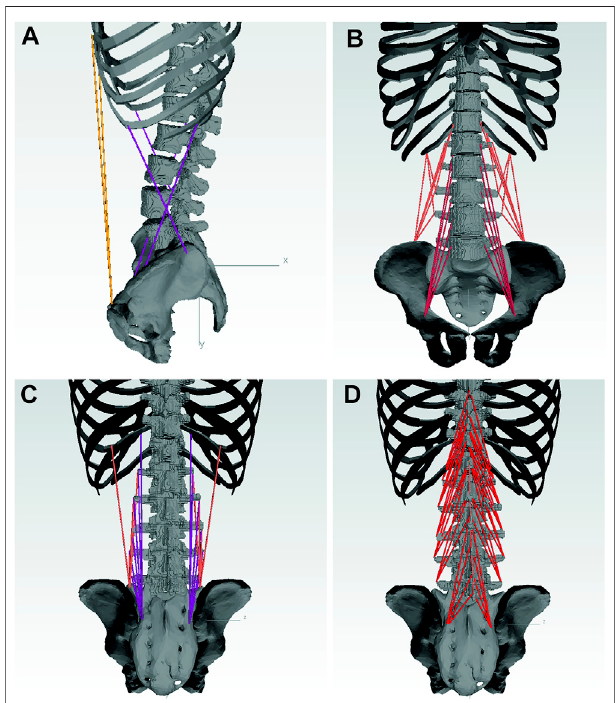
FIGURE 5 | Musclegroups included in the model with: RA, EO, IO (A) ; QL, PM (B) ; LL, IL (C) ; MF, IS (D)